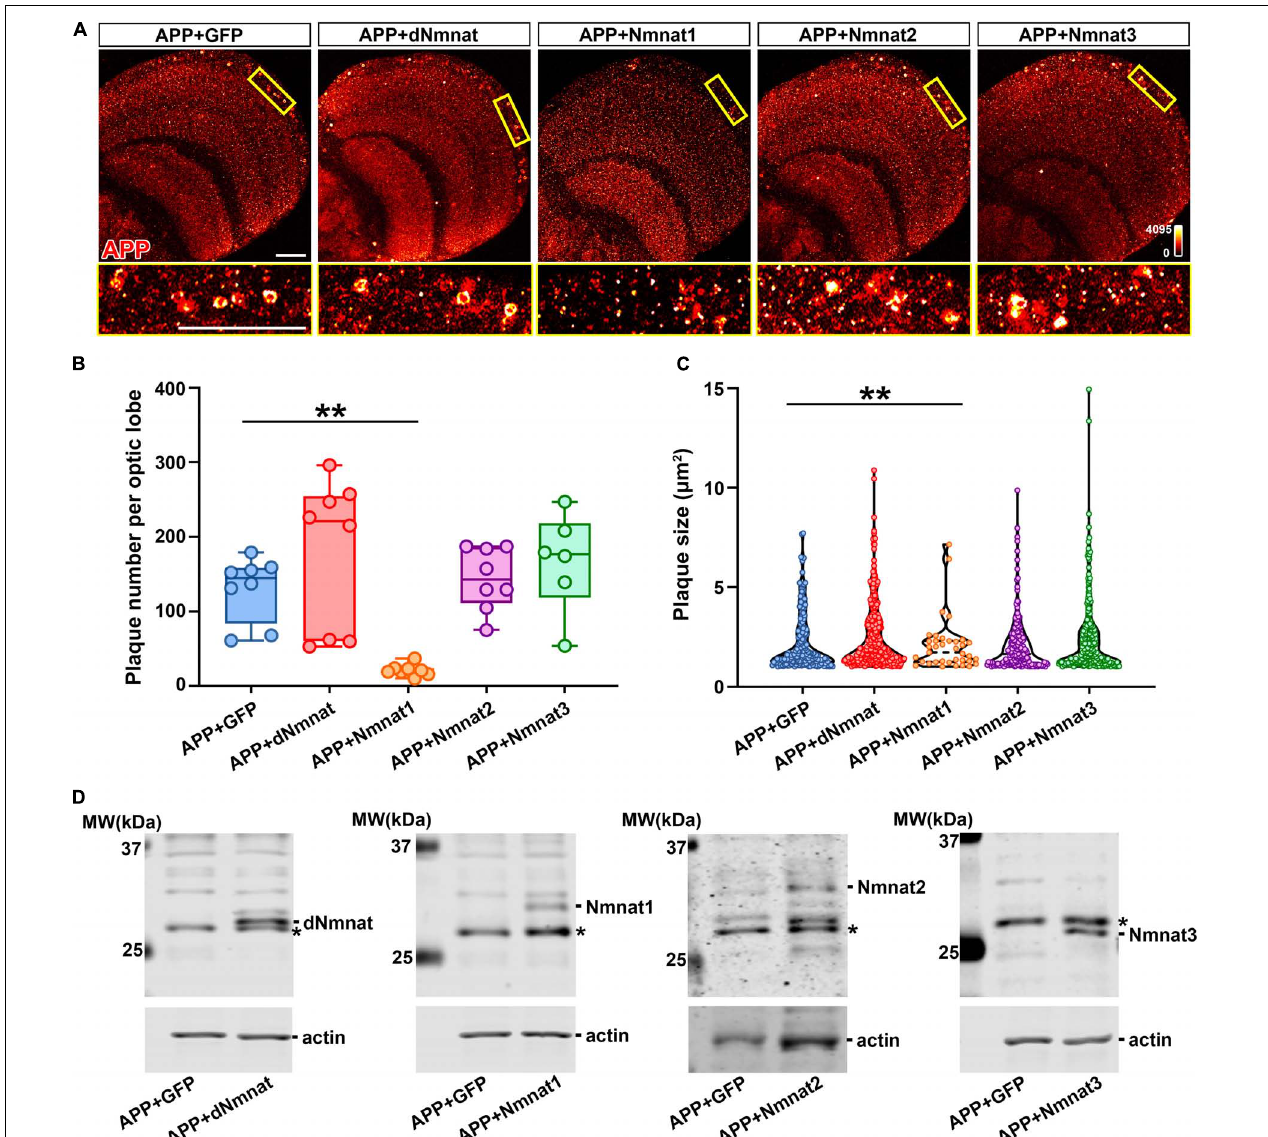
FIGURE 2 | hNmnat1 reduces the accumulation of amyloid plaques in the brain. (A) Top row: APP staining (heatmap) of brains of flies expressing APP + GFP, APP + dNmnat, APP + hNmnat1, APP + hNmnat2, or APP + hNmnat3 at 60 DAE. Bottom row: higher magnification images of the boxed areas in the top row. Scale bars = 30 µ m. (B) Scatter plot showing quantification of the number of amyloid plaques in panel (A) . The whiskers represent the minimum and maximum values of the dataset. One-way ANOVA with Bonferroni’s post hoc test. n = 6–8/group, ** P < 0.01. (C) Violin plot showing quantification of the size of amyloid plaques in panel (A) . One-way ANOVA with Bonferroni’s post hoc test. ** P < 0.01. (D) Western blot analysis showing expression of Nmnat isoforms in fly brains at 60 DAE. Actin is used as an internal control. * Indicates a non-specific